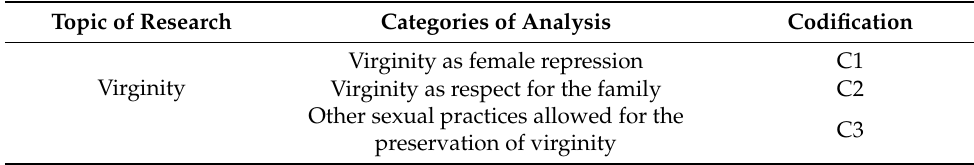
Table 1. Coding of the focus group categories. Topic of